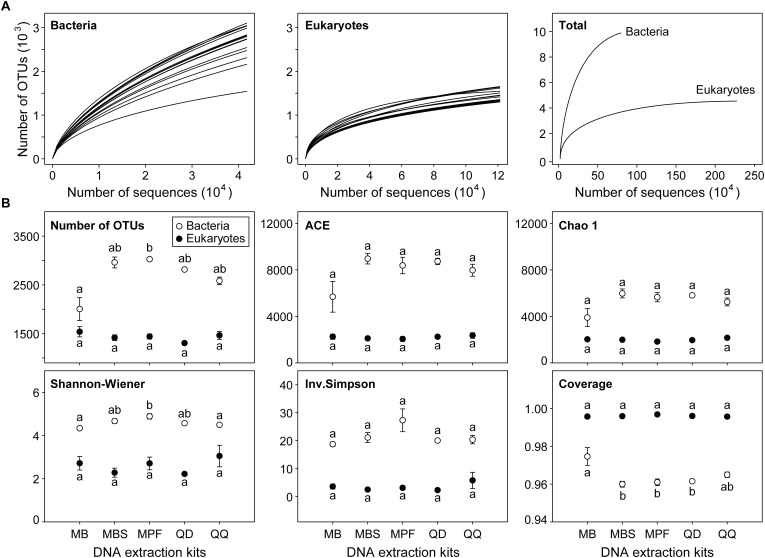
The effect of DNA extraction kits on α-diversity of both bacterial and eukaryotic plankton. (A) Rarefaction curves of each single community and the combined communities for bacteria and eukaryotes, respectively. (B) Comparison of community diversity parameters. The OTUs were defined at 97% sequence similarity level. All data are means ± standard error (n = 3). Significant difference (P < 0.05) is indicated by different letters of the alphabet, and the significance is calculated by non-parametric Kruskal-Wallis test.